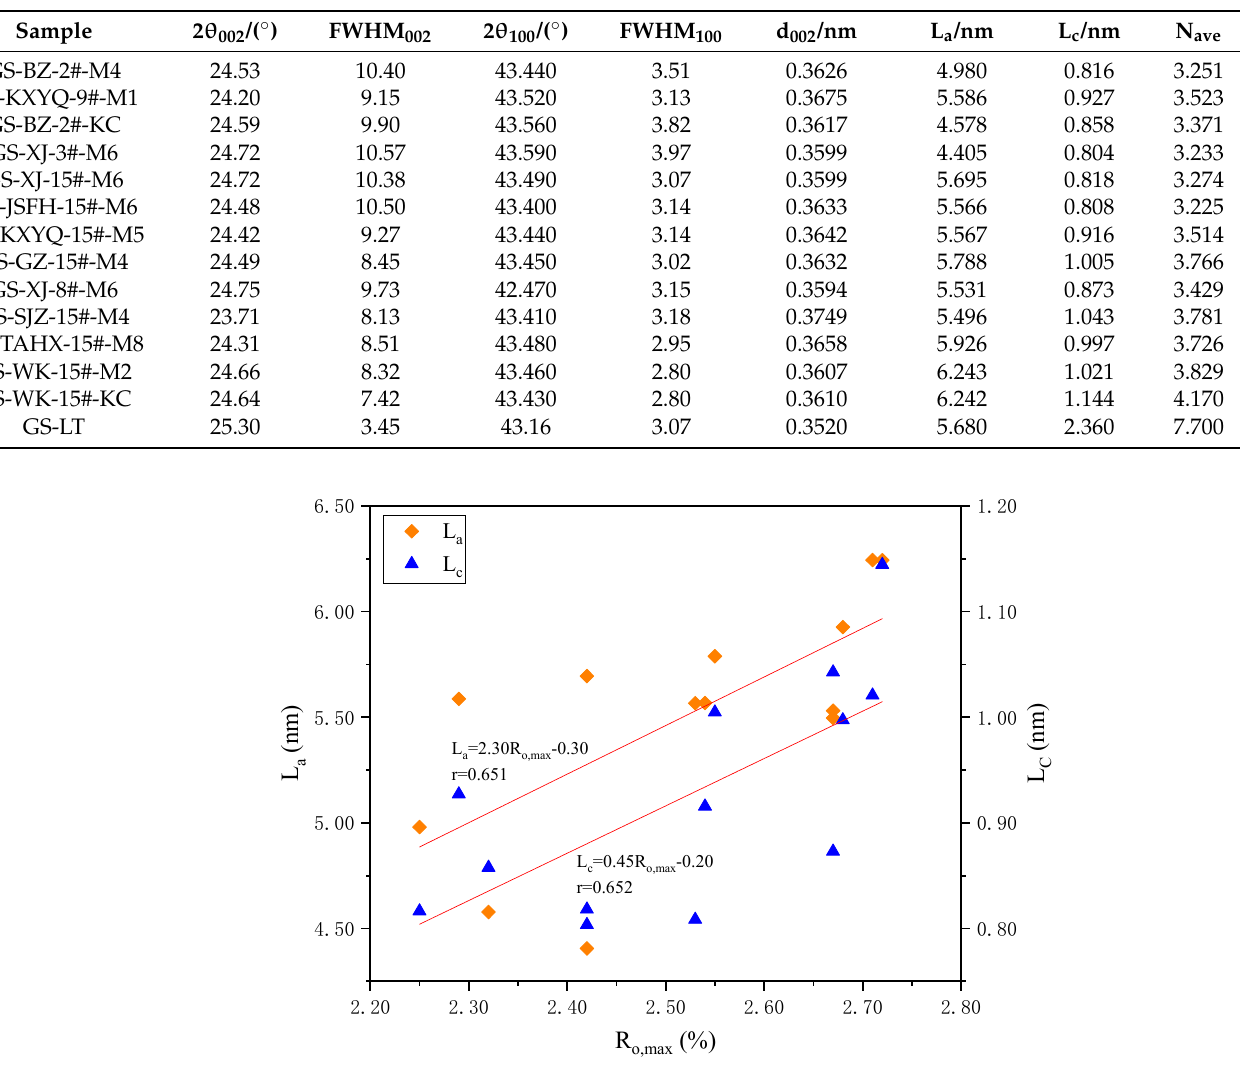
Figure 6. Scatter diagram of L a and L c of coal-based graphene.